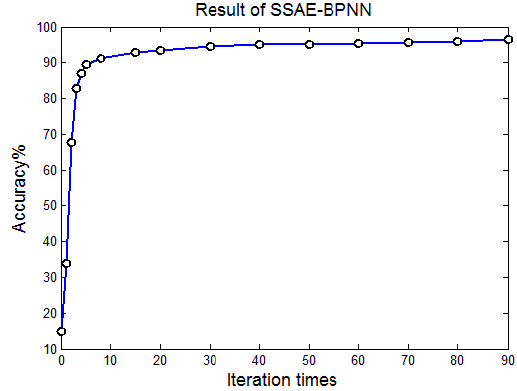
Figure 11. Influence of iteration times on classification accuracy.